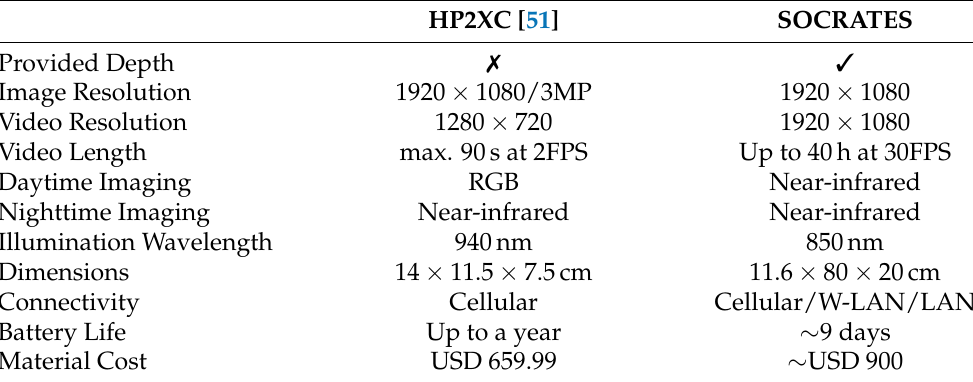
Table 1. Comparison between SOCRATES and the widely used Reconyx HP2XC trail camera. The video length of SOCRATES is only bounded by the available persistent storage space, although we used 25s videos for our experiments. Costs include only materials and not